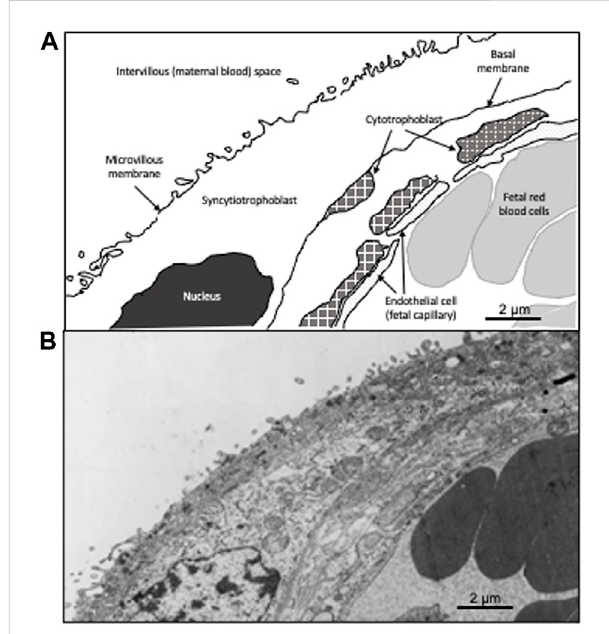
FIGURE 1 Drawing of a villous cross-section of a human placenta. A cross- section of the villous tissue of the human placenta. (A) is a schematic showing the composition the maternal fetal interface. The outer layer is comprised of multi-nucleated syncytiotrophoblast in contact with the maternal blood. The second layer is comprised of mononucleated cytotrophoblast, which fuse to form the syncytiotrophoblast. Below the cytotrophoblast is the endothelial wall of the fetal capillary. Fetal red blood cells (erythrocytes) are present in the fetal capillary. (B) shows the transmission electron micrograph of the placenta that was used to generate (A) . The dark cells on the right are fetal erythrocytes while the space on the upper left is the maternal blood (intervillous) space. The two circulatory systems are separated by the syncytiotrophoblast and the